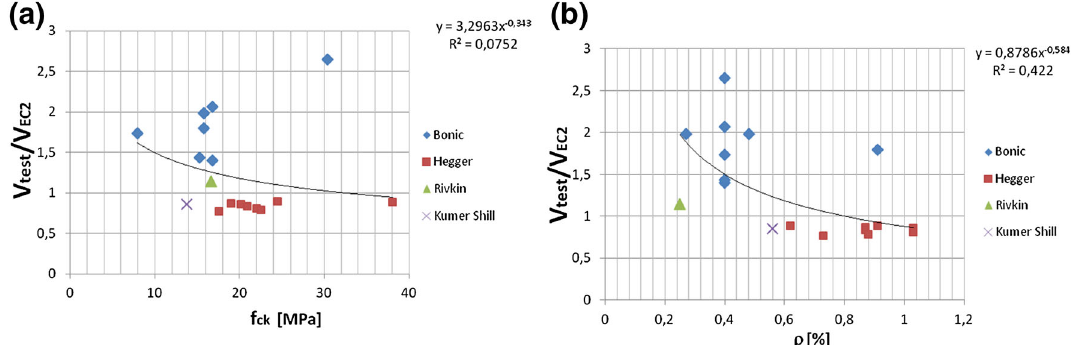
Fig. 15 Comparison of the results of the punching tests and punching capacity according to Eurocode 2 regarding: a concrete compressive strength ( f ck ); b reinforcement ratio ( q l